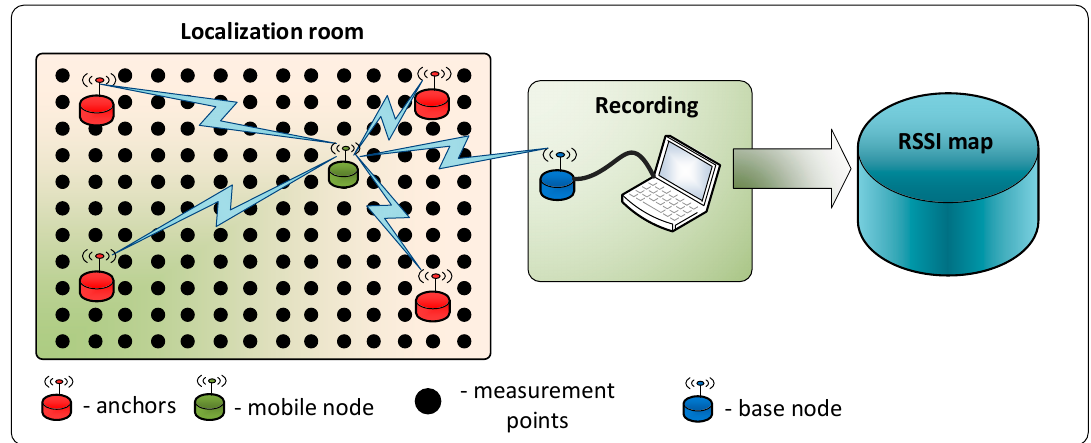
Figure 4. Offline phase of the fingerprint localization.